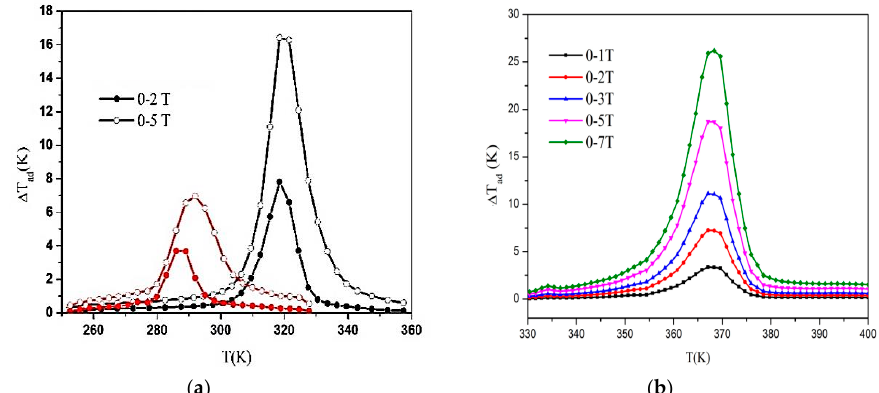
Figure 10. Adiabatic temperature determination for ( a ) Mn 1.3 Fe 0.7 P 0.35 Si 0.65 (red) and Mn 0.7 Fe 1.3 P 0.65 Si 0.35 (black) under 0–2 T (black dots) and 0–5 T (open circles) magnetic field variations respectively and ( b ) MnFeP 0.5 Si 0.5 for several magnetic field shifts.